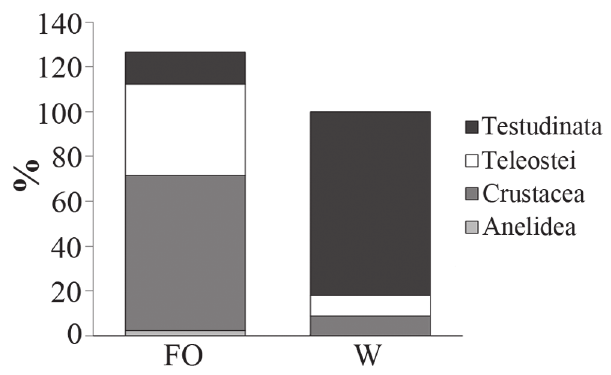
reinforce the coney as an opportunistic predator. We have observed predation on seasonal resources as green turtle ( Chelonia mydas ) hatchlings, which represents the first record of this type of prey for C. fulva . Trindade Island, where a large amount of offspring hatch during four months every year (Moreira et al. , 1995), is the third largest reproductive site of C. mydas in the Atlantic ocean (Seminoff, 2002). Sea turtle hatchlings are known as a seasonal resource of high energy value for many opportunistic predators (Bouchard & Bjorndal, 2000). Considering the high abundance of C. fulva and that 9% of the sampled individuals were found to feed on green turtles, their estimated predation pressure on green turtles could be reasonably high around the shallow habitats of Trindade Island. In fact, C. fulva is an opportunistic predator that uses different foraging tactics (Sazima et al. , 2005).